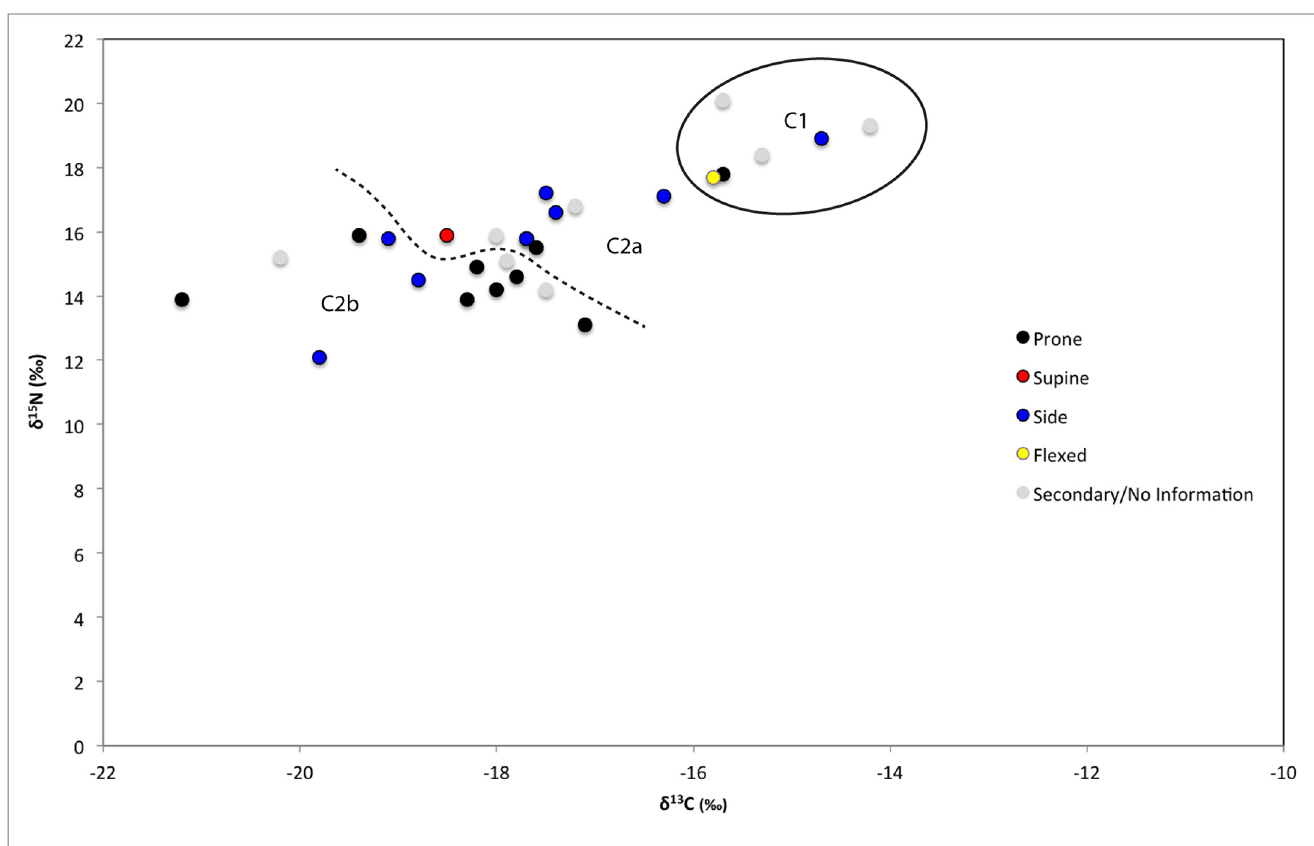
Fig 7. Human bone collagen δ 15 N and δ 13 C values from Wairau Bar coded with burial position